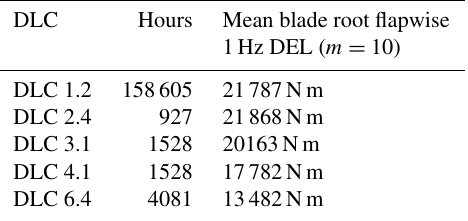
Table 4. Qualitative breakdown of the fatigue load contributions of various design load cases for the IEA10MW (based on the loads reported in Bortolotti et al., 2019). Hour distribution is based on a 20-year lifetime.